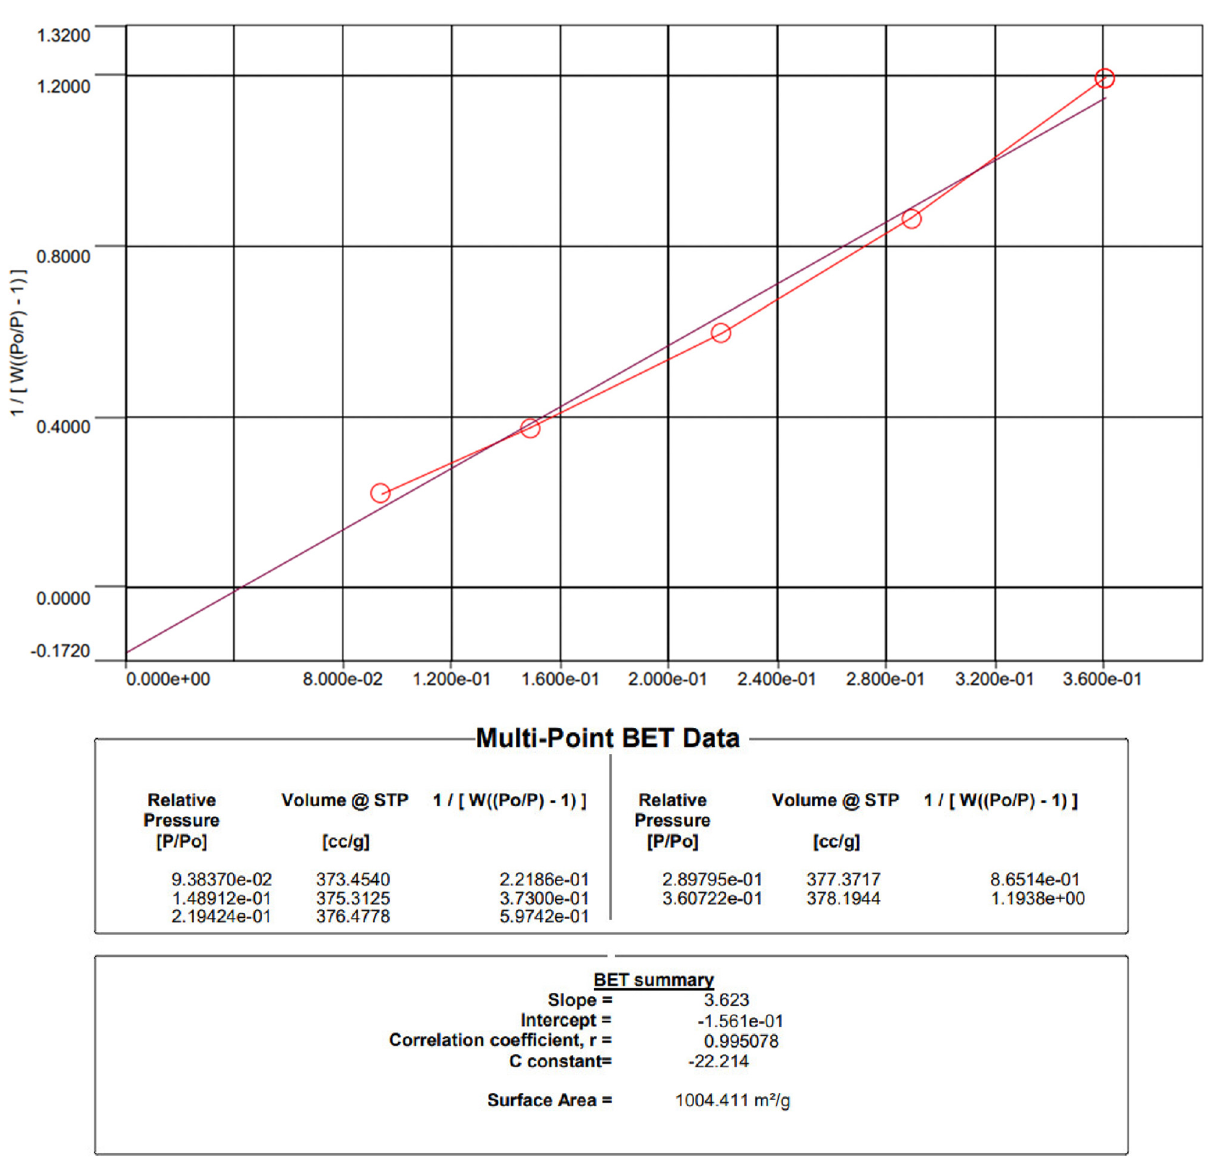
Figure A6: Nitrogen adsorption – desorption isotherm of CuZn -